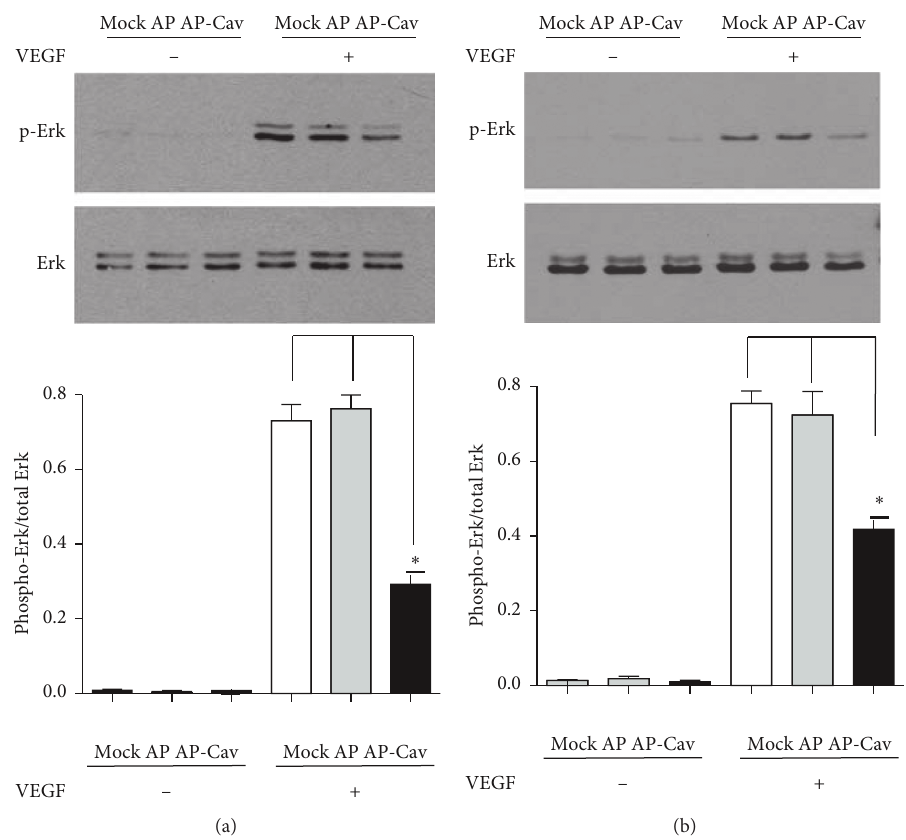
Figure 2: AP-Cav inhibits ERK1/2 phosphorylation. (a) After overnight low serum starvation, the sample was treated for 30 minutes with the AP-Cav peptide and then was stimulated with 50 ng VEGF/ml for 10 minutes. (b) After overnight low serum starvation, 30 minutes AP- Cav peptide treatment, and stimulation with 50ng VEGF/ml for 2 hours, the ERK1/2 phosphorylation level was determined. Cells were treated with peptide for 30 minutes and then stimulated with 50ng/ml of VEGF at the indicated times. At the end of the stimulation, cells were immediately lysed in RIPA buffer. The lysates were subjected to SDS-PAGE and western blot analysis with specific antibodies for phospho-ERK 1/2 and total ERK 1/2. Bar graph represents the phospho-ERK 1/2 to total ERK 1/2 ratio normalized to beta-actin levels. The data are mean ± s.e.m. from three independent experiments, ∗ p < 0 .